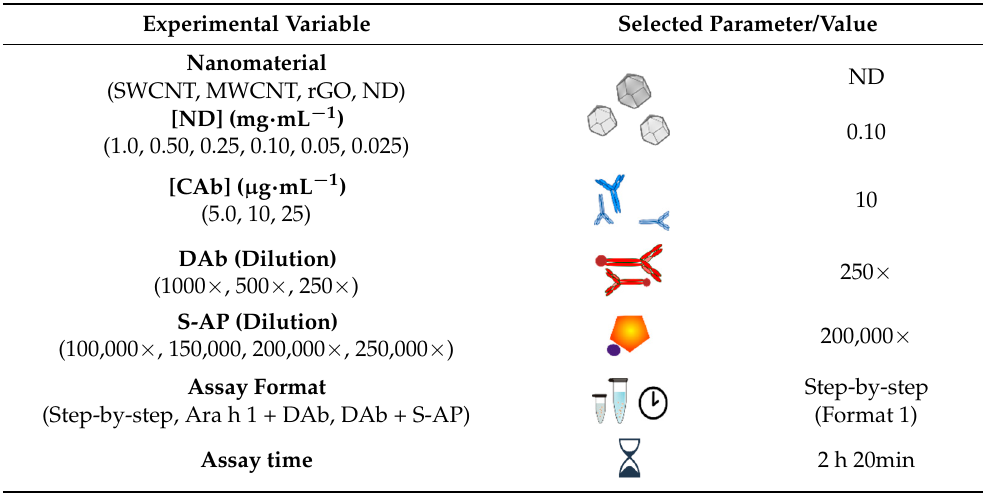
Table 1. Experimental variable optimization for the voltammetric immunosensor. Experimental Variable Selected Parameter/Value Nanomaterial